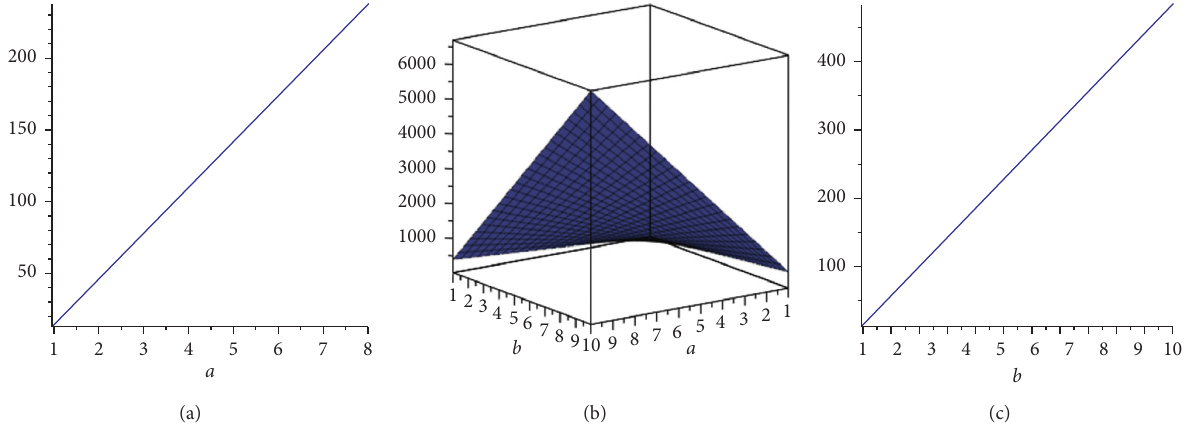
Figure 7: FI ( SiC